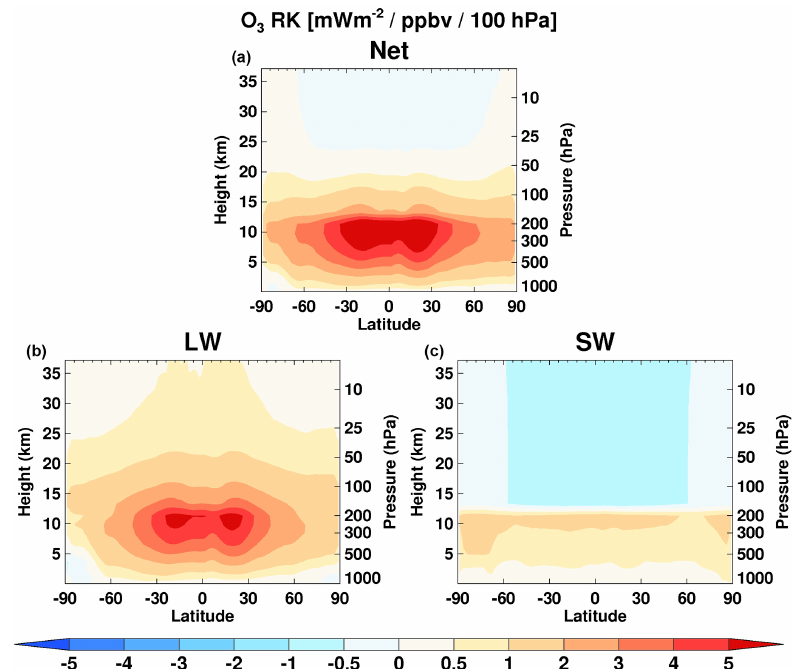
Figure 1. Annual zonal mean whole atmosphere ozone radiative kernel under all-sky conditions for (a) net (LW + SW), (b) LW, and (c) SW